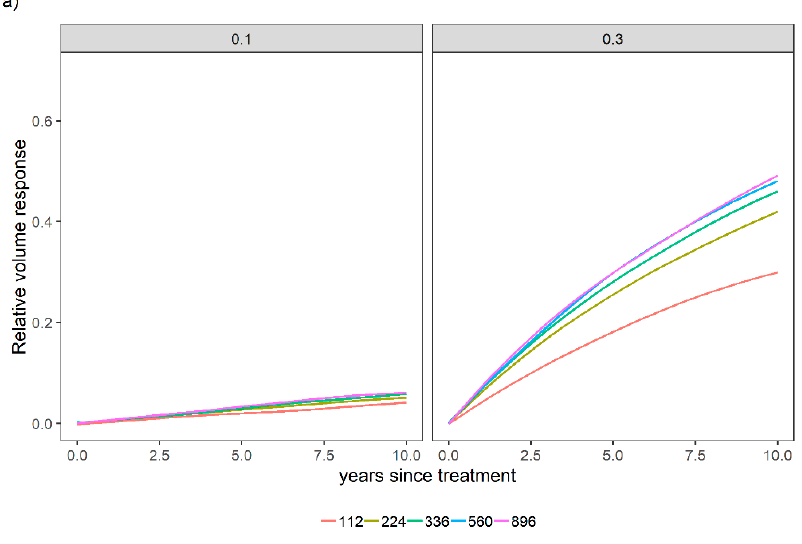
Figure 8. Relative stand-level volume response for two initial site index scenarios [15 m and 25 m] across different levels of N (112, 224, 336, 560, and 896 kg ha − 1 ) over time (years since treatment was established) when P was not applied (a) or when 28 kg ha − 1 of P was applied (b). Relative spacing was held constant (RS = 0.20).